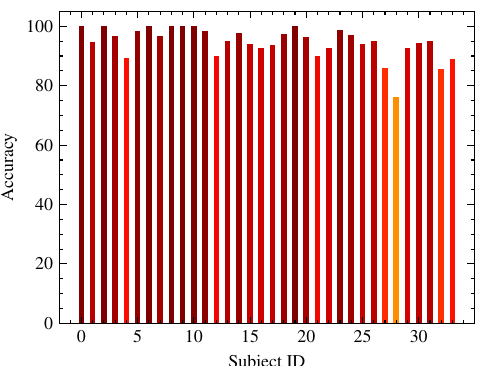
Figure 5. The subset detection accuracy of all subjects in the OSFM dataset. The horizontal axis is the subject ID in the OSFM dataset and the vertical axis is the frame-wise fatigue state accuracy of the subjects.